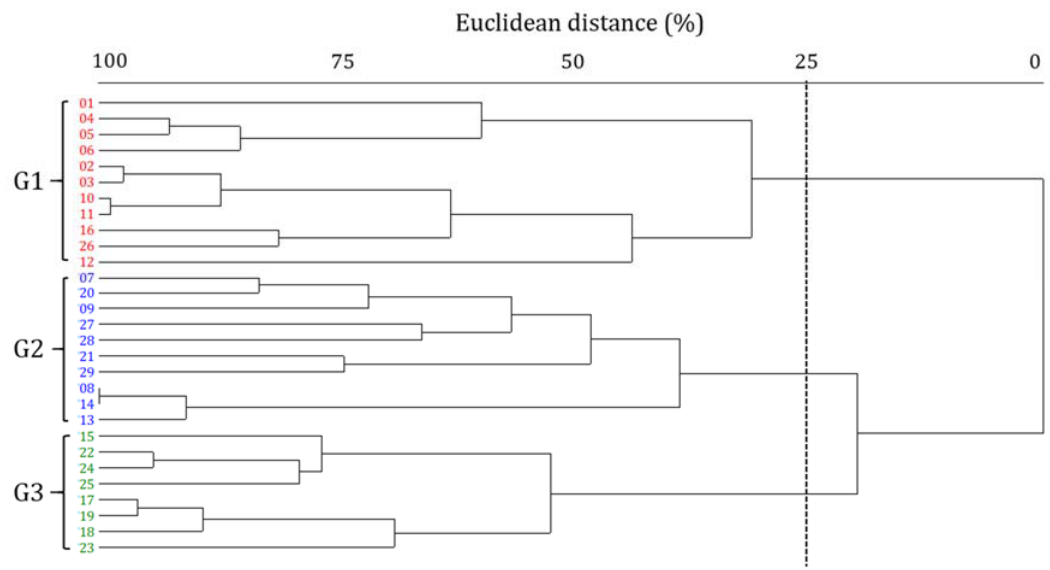
Figure 3. Dendrogram of on the epilithic diatom communities of 29 sampling sites of the Hantangang River, Korea, from 2012–2015. Table 1. Physicochemical and biological variables of the epilithic diatom communities (G1–3) in the Hantangang River, from 2012 to 2015.